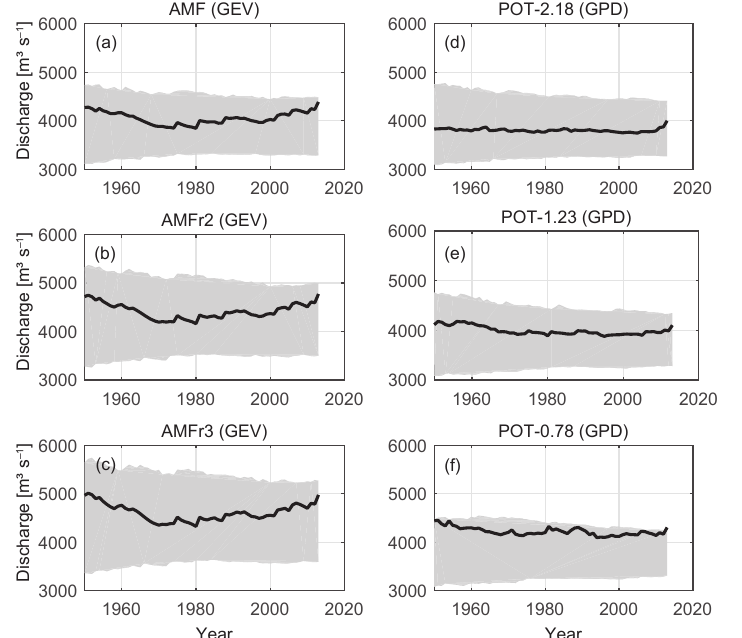
Figure 4. Time-dependent 100-year floods (thick black line) from 1950 to 2013 derived by extreme value statistics and the different flood indicators. The grey area refer to the 90% confidence